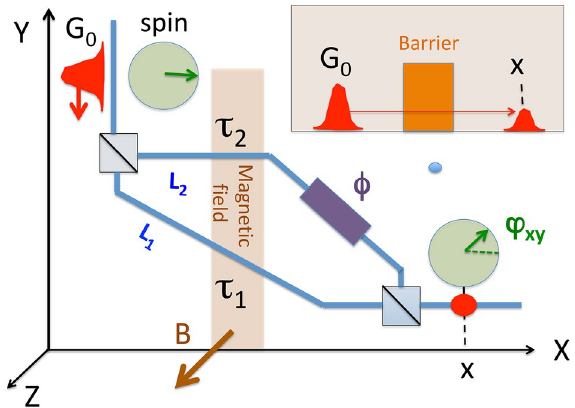
Figure 1. A particle reaches the final position x after passing through an interferometer, and a weekly coupled Larmor clock is used to determine the duration it spends in the magnetic field. The case of tunnelling across a potential barrier, shown in the inset, is more complicated, yet conceptually